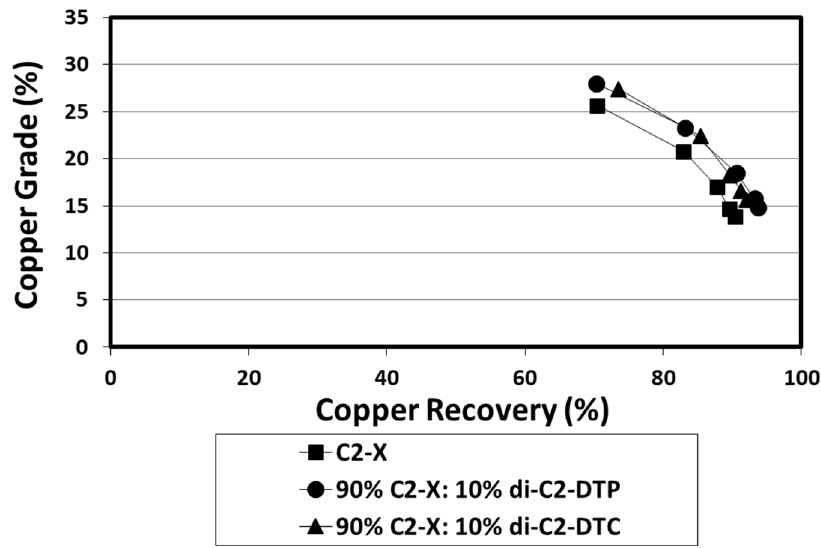
Figure 12. Cumulative copper grade recovery with respect to C2-X (individual xanthate), C2-X (90%):di-C2-DTP (10%) and C2-X (90%):di-C2-DTC (10%) [63]. Table 5. Species responsible for the surface hydrophobicity of copper minerals [63]. Mineral